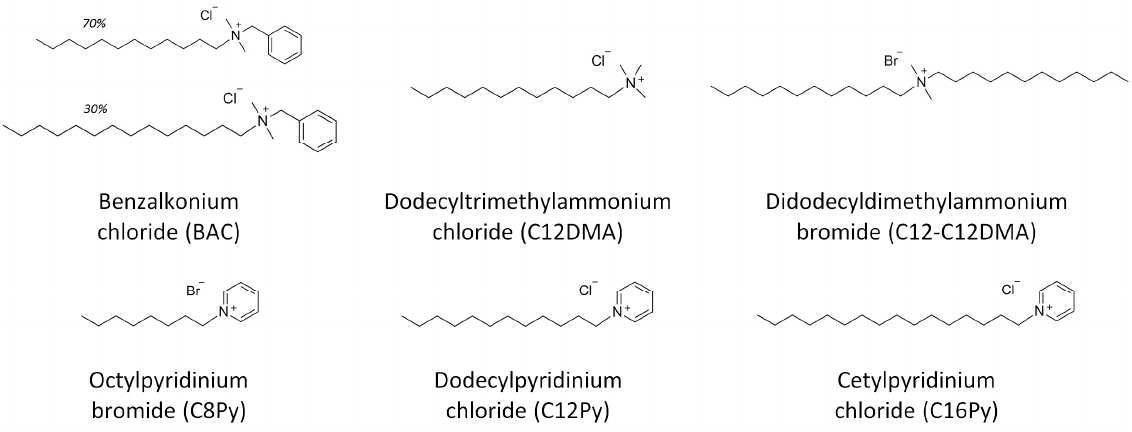
Figure 1. Molecular structure of cationic surfactants under study.